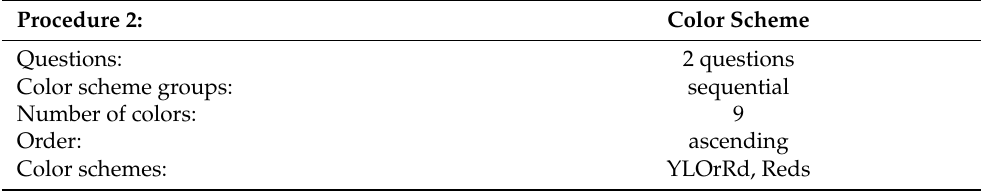
Table 10. Header of the second procedure.